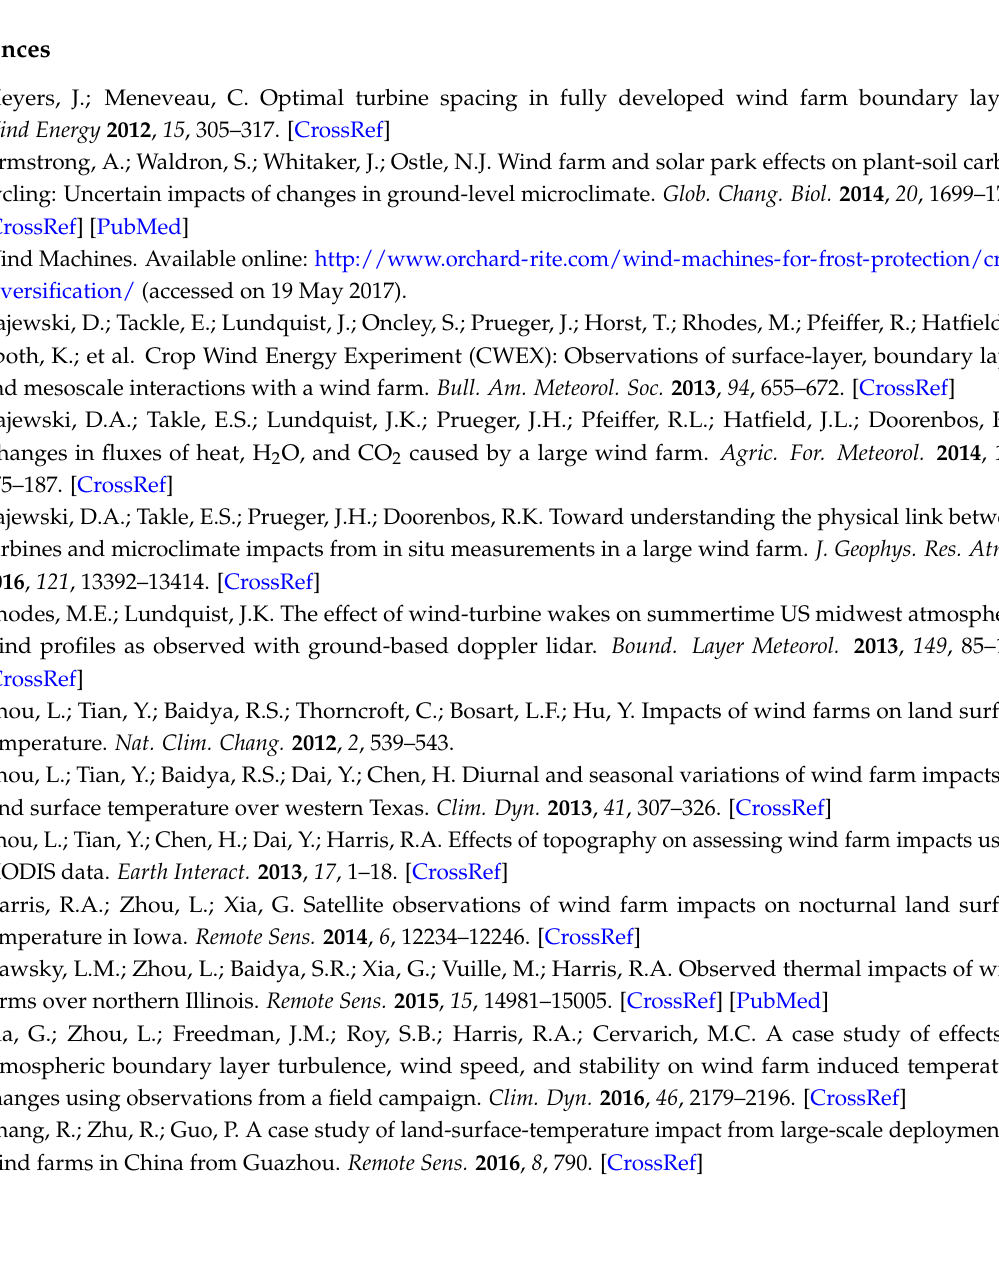
Table S1: Areal mean DNDVI for WFPs and NWFPs during JJA and the growing season (in parenthesis) in Illinois and Texas; Figure S1: Spatial patterns of NDVI climatology (2003–2014) during JJA and the growing season; Figure S2: The geographical location of wind farm pixels (WFPs, in red) and non-wind farm pixels (NWFPs, in blue); Figure S3: Spatial patterns of DNDVI (2010–2014 averages minus 2003–2004 averages) during JJA and the growing season; Figure S4: Scatter plots of NDVI anomalies for the pre- (2003–2004) and post- (2010–2014) turbine periods; Figure S5: Box-and-whisker diagrams of DNDVI (2010–2014 averages minus 2003–2004 averages) over WFP and NWFPs in Illinois and Texas respectively; Figure S6: Interannual variations in areal mean ∆ NDVI (WFPs minus NWFPs) in Illinois and Texas for the period 2003–2014 during JJA and the growing season; Figure S7: The seasonal cycle of monthly mean NDVI for the pre- (2003–2004, solid) and post- (2010–2014, dashed) turbine periods and DNDVI (2010–2014 averages minus 2003–2004 averages) averaged over WFPs (red) and NWFPs